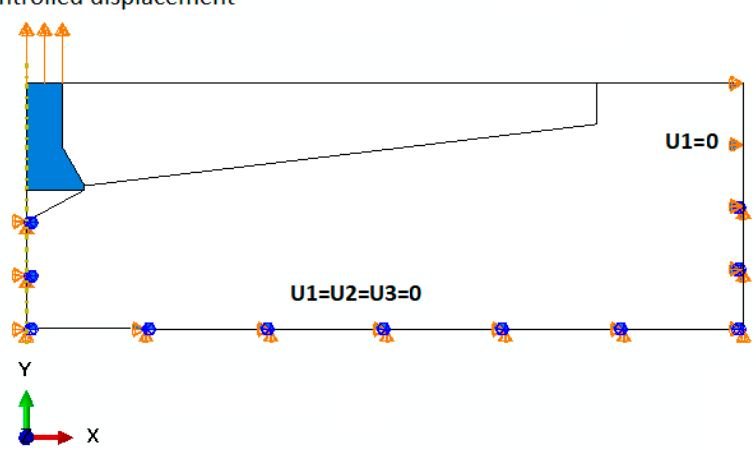
Figure 4. Model boundary conditions.